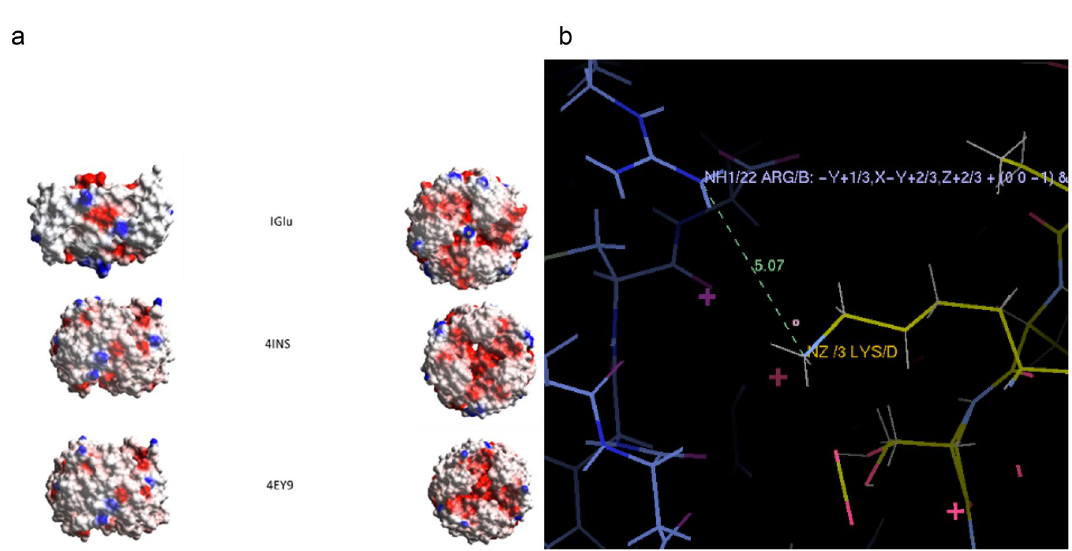
Figure 5. ( a ) The electrostatic surfaces of the hexamer of IGlu, 4INS and 4EY9 side view (left) and top view from the three fold axis (right). ( b ) D3Lys and B22Arg (symmetry) are both positively charged and in only 5.07 Å distance which contributes to the electrostatic repulsion. Figures created using COOT